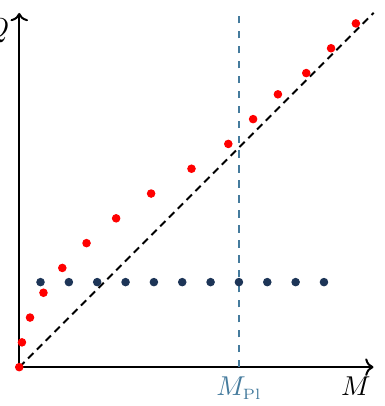
Figure 3. Super-extremal states for weakly coupled open (blue dots) versus heterotic strings (red dots). For a fixed value of the dilaton, the open string only provides a finite number of super- extremal states, while the heterotic string contains a marginally super-extremal tower of